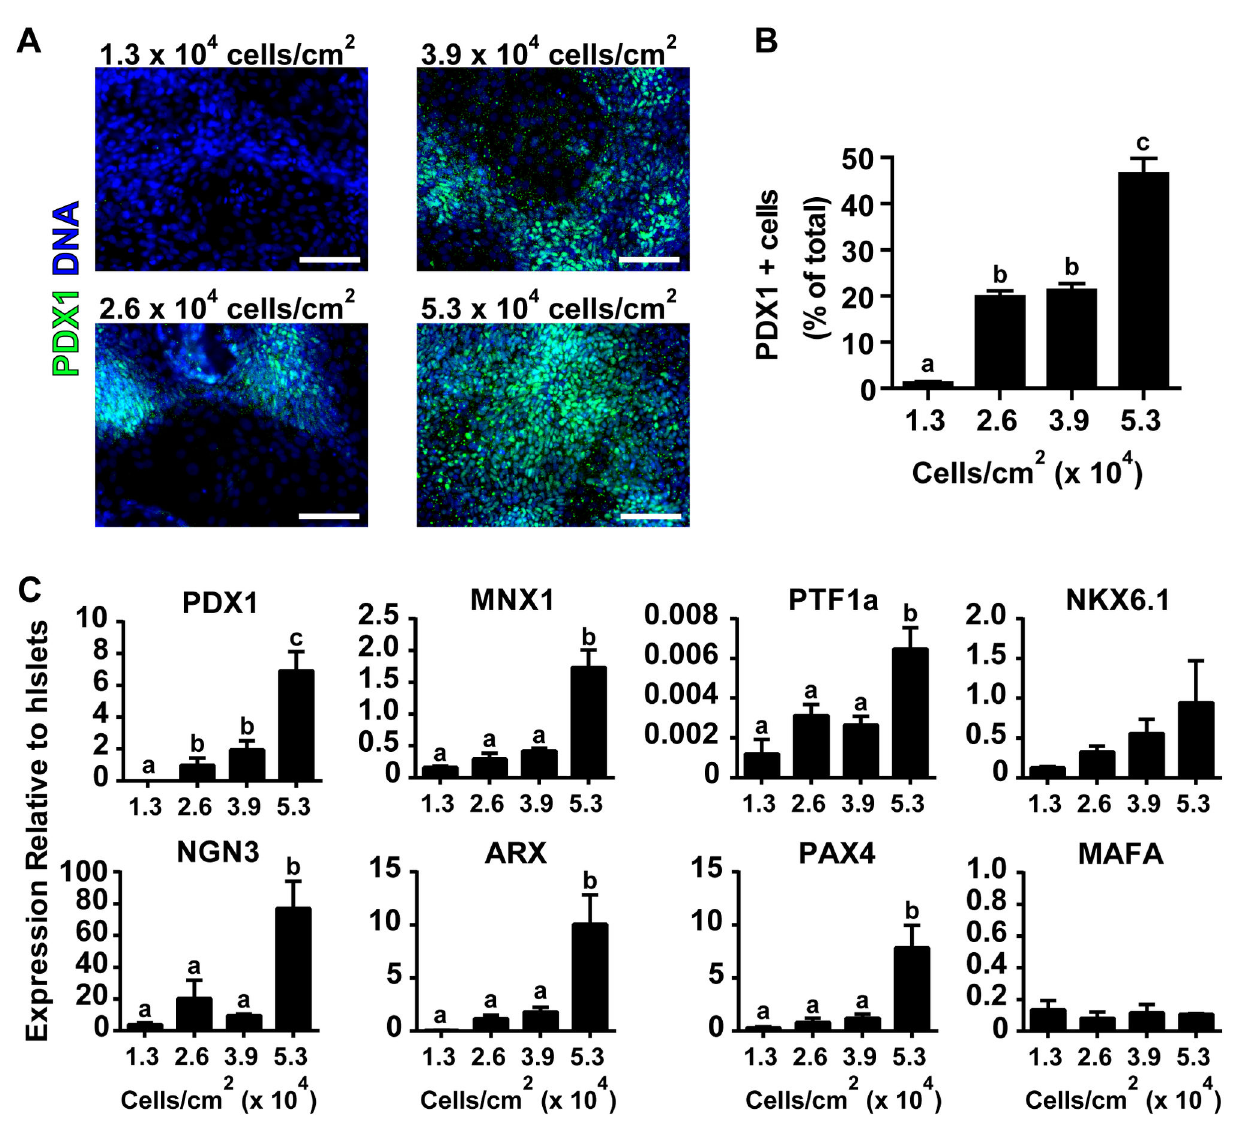
Figure 3. High Cell Seeding Density Increases Pancreatic Progenitor Differentiation. (A) hESCs seeded at different densities were differentiated for 14 days and immunostained for PDX1 (green) and DNA (blue). (B) Single-cell quantification of PDX1 positive nuclei as a percentage of total nuclei (C) RT-qPCR of 21 day differentiated cells. Expression is shown relative to isolated human islets. Different superscripts (a, b, c) are significantly different from each other within each graph by one-way ANOVA with Bonferroni post-hoc test. Scale bars are 100